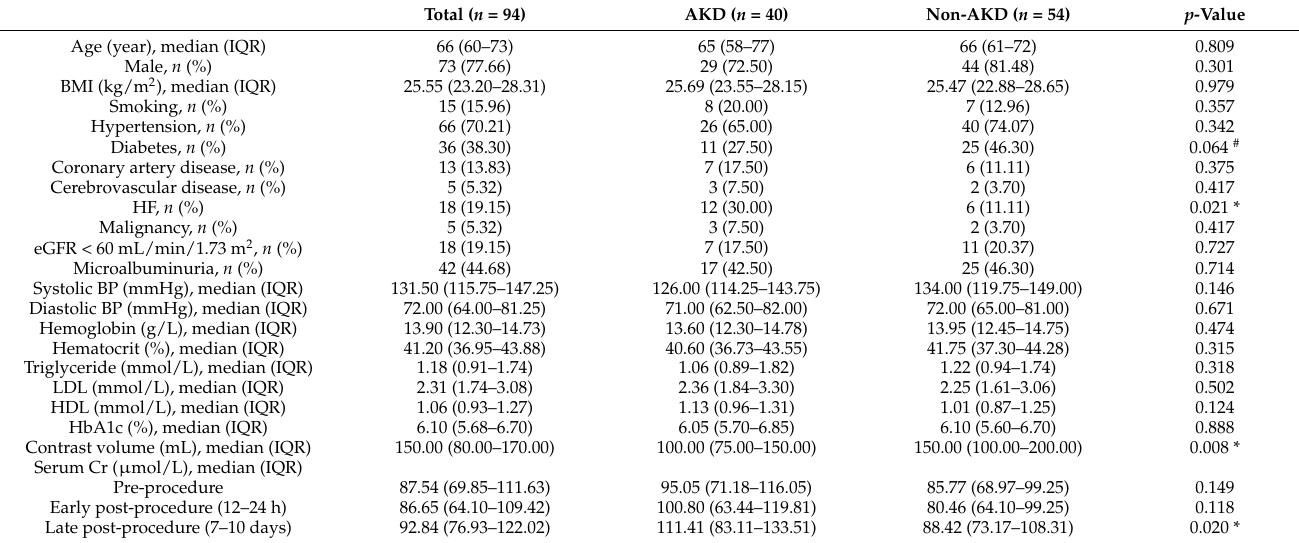
Table 1. Characteristics of the Enrolled